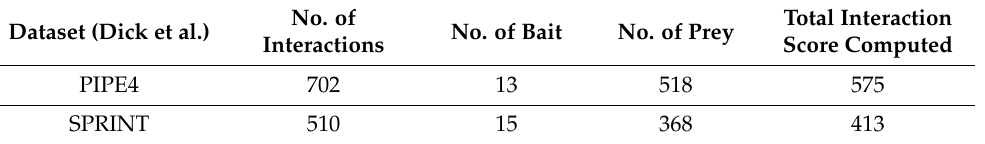
Table 8. Detailed validation of our model compared to all Human–nCov Datasets proposed by Dick et al. Dataset (Dick et